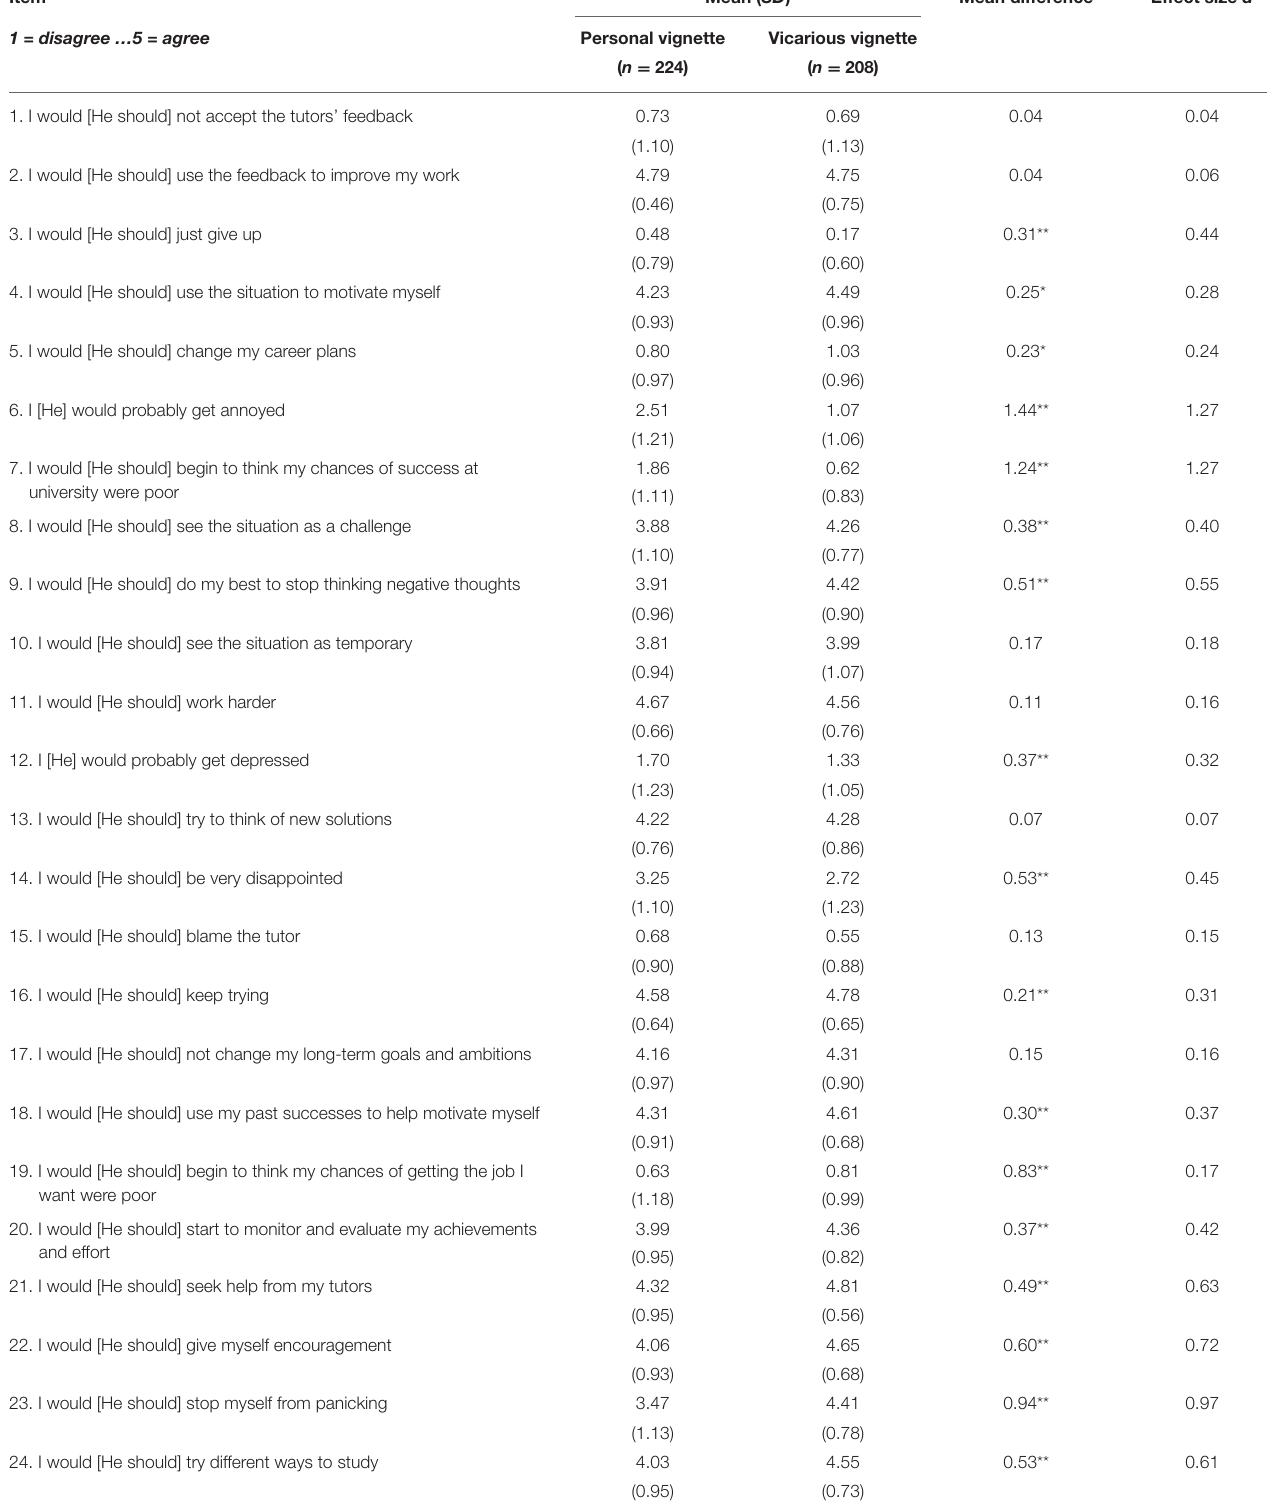
TABLE 7 | Academic resilience scaleitem mean scores by vignette group.